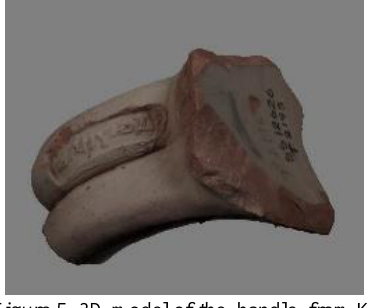
Figure 5. 3D model of the handle from Kos